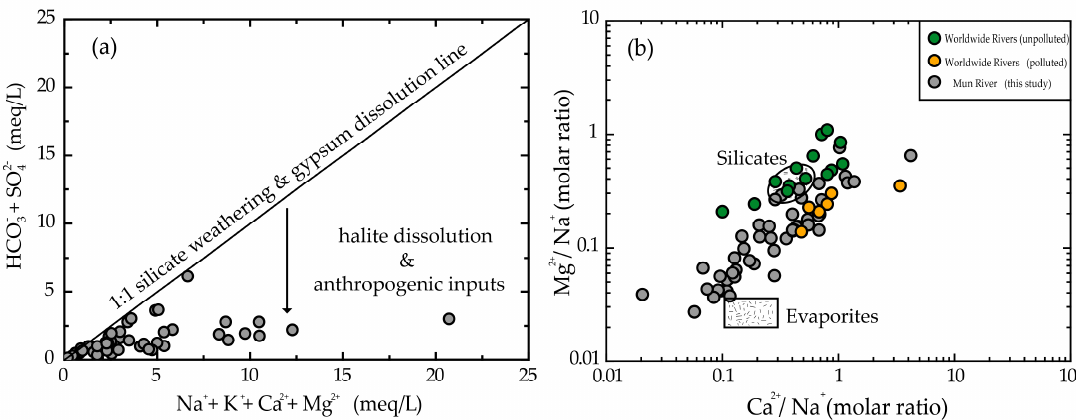
Figure 5. The elemental ratios in Mun River water: ( a ) The covariation of the equivalent ratios of (SO 42 − + HCO 3 − ) vs. (Na + + K + + Ca 2+ + Mg 2+ ); ( b ) mixing diagrams using ( Mg 2+ /Na + ) vs. ( Ca 2+ /Na + ). The gray points are the Mun River waters (this paper). The green points represent the world rivers with good water quality, while the orange points are polluted rivers. The world rivers are the 60 largest rivers of the world, and the polluted rivers have high TDS values (greater than 500 mg / L; [11]). The silicate and evaporite end-members are the rivers’ drain monolithology [11].